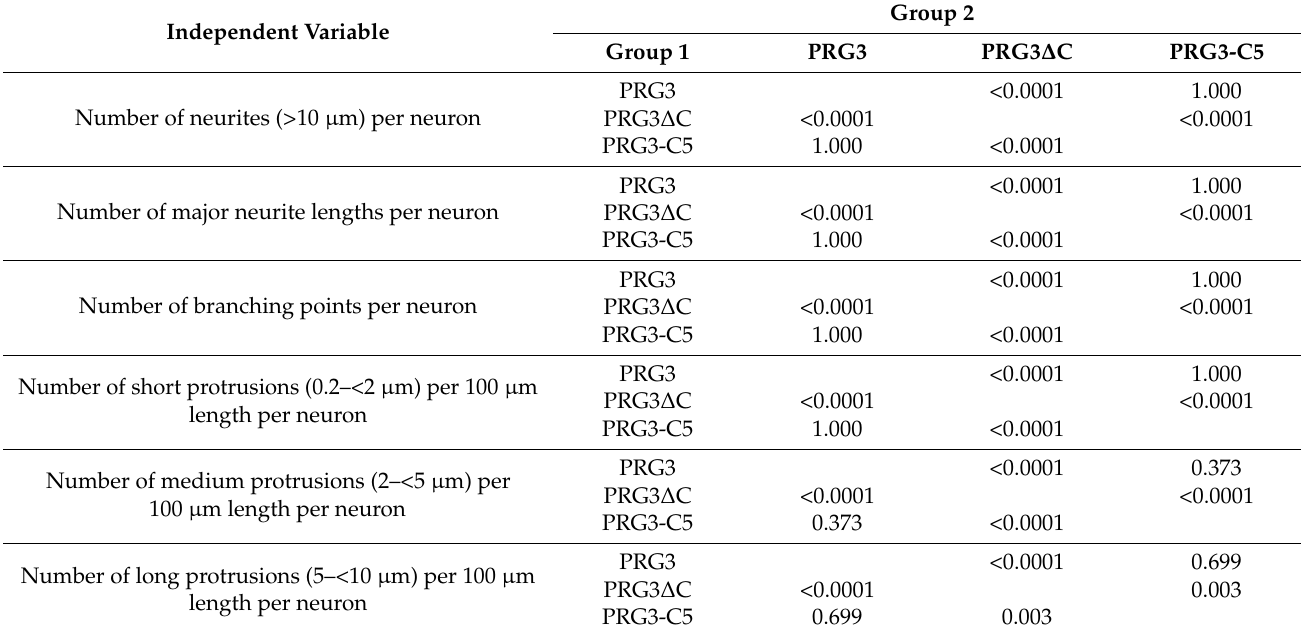
Table 1. Summary of p values of pairwise comparisons obtained by the Kruskal–Wallis test followed by a post hoc Dunn’s test of data presented in Figure